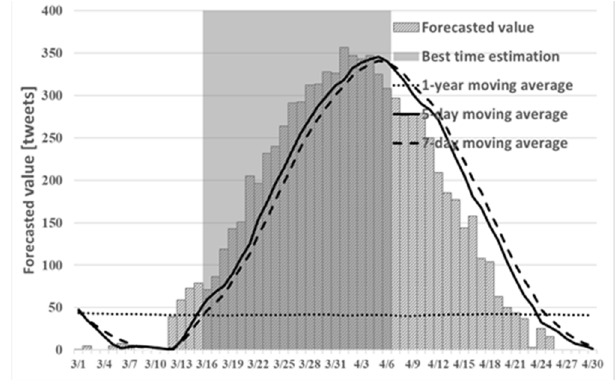
Figure 11. Tokyo after forecasting in 2021 (proposed method (2)).